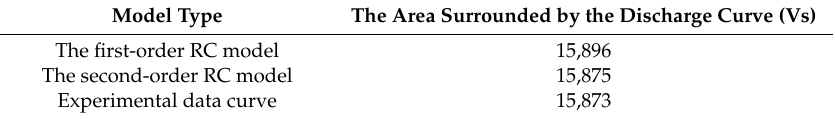
Table 6. The area surrounded by the discharge curve of the first-order and the second-order models for UDDS